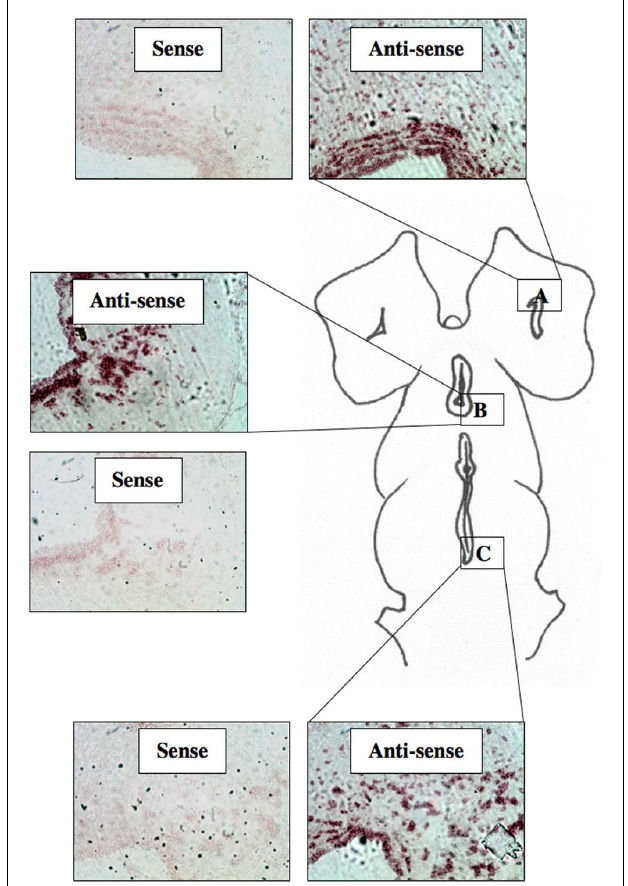
FIGURE 2 | Fidelity of estrogen receptor and GnRH-III (DIG-labeled) probes. Probe fidelity was supported through Dot Blot analysis that revealed binding of ER1, ER2, and LIII (GnRH-III) to respective cDNAs.